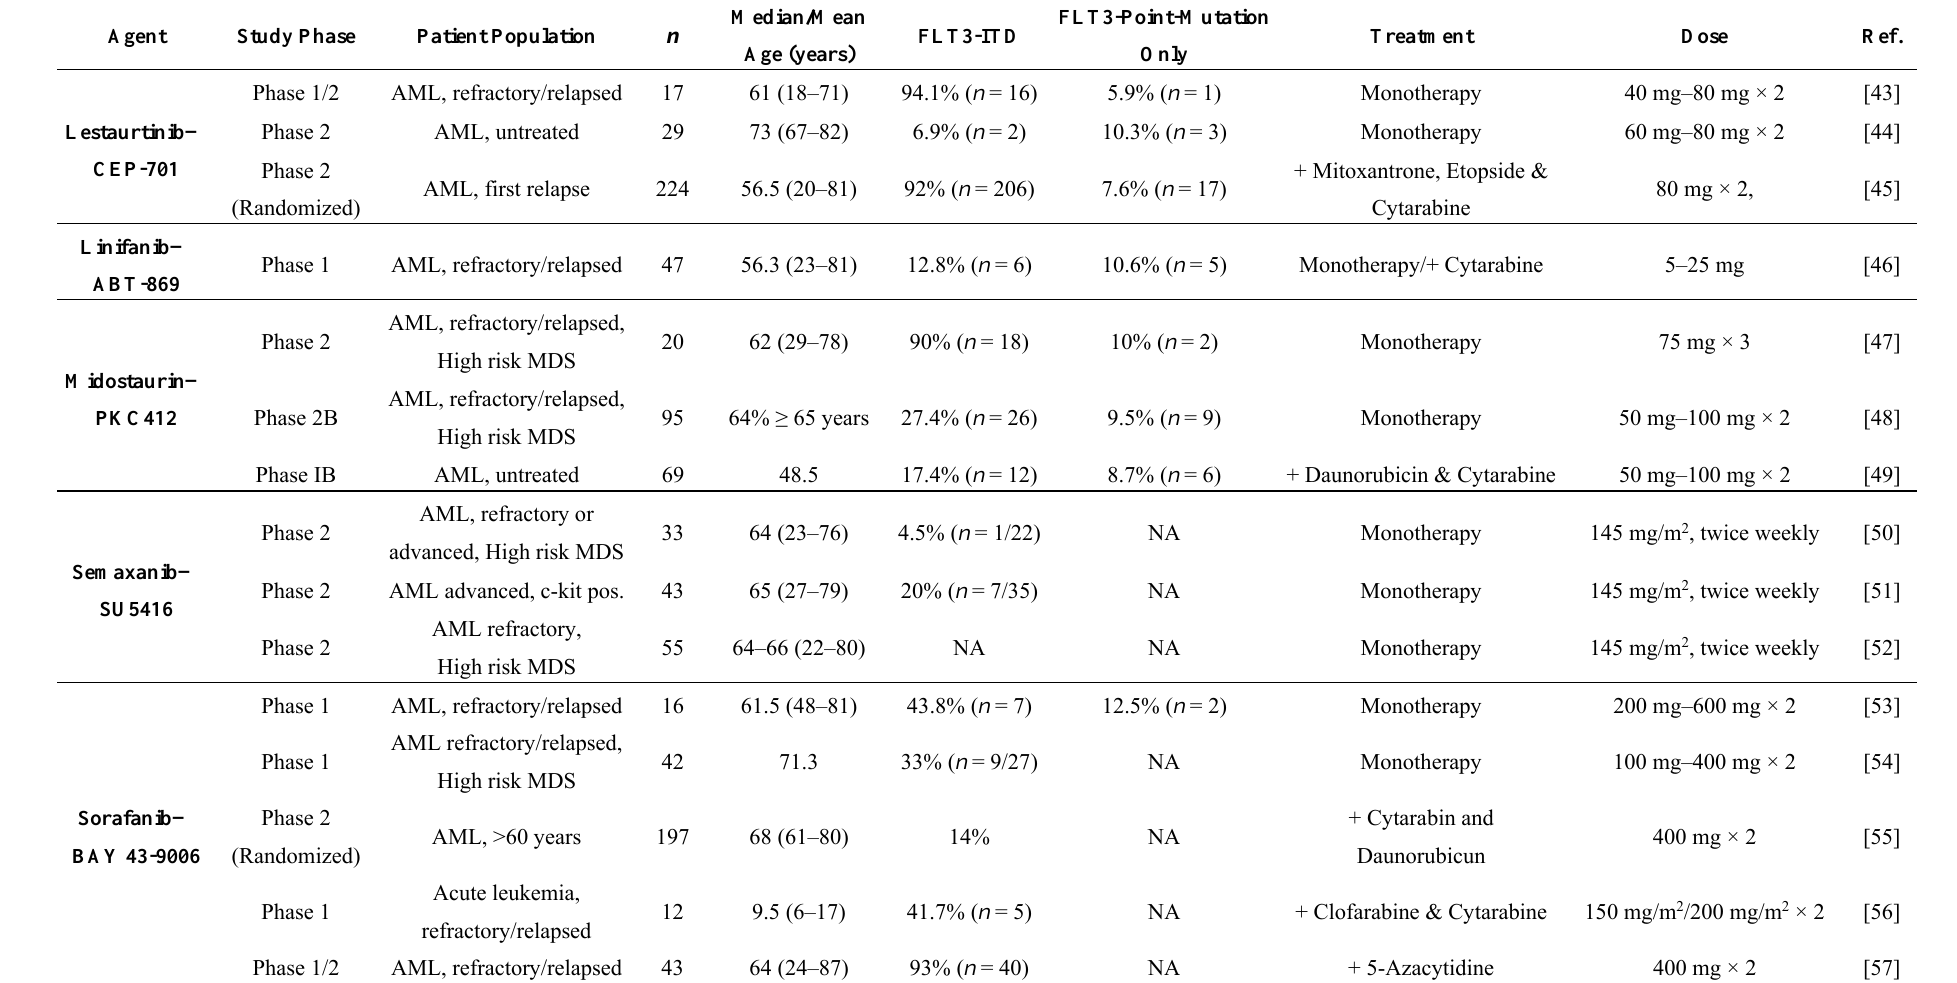
Table 1. Overview of evaluated clinical